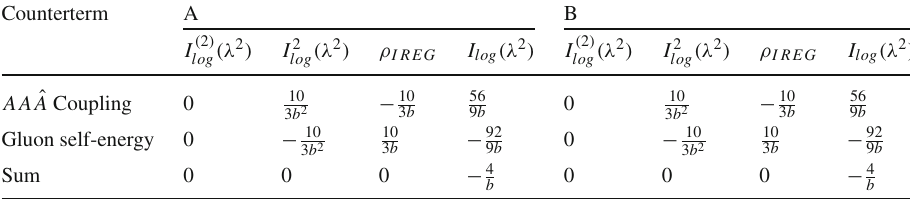
Table 17 Results for fermionic part of QCD using IREG where ρ = I (λ 2 ) IREG log